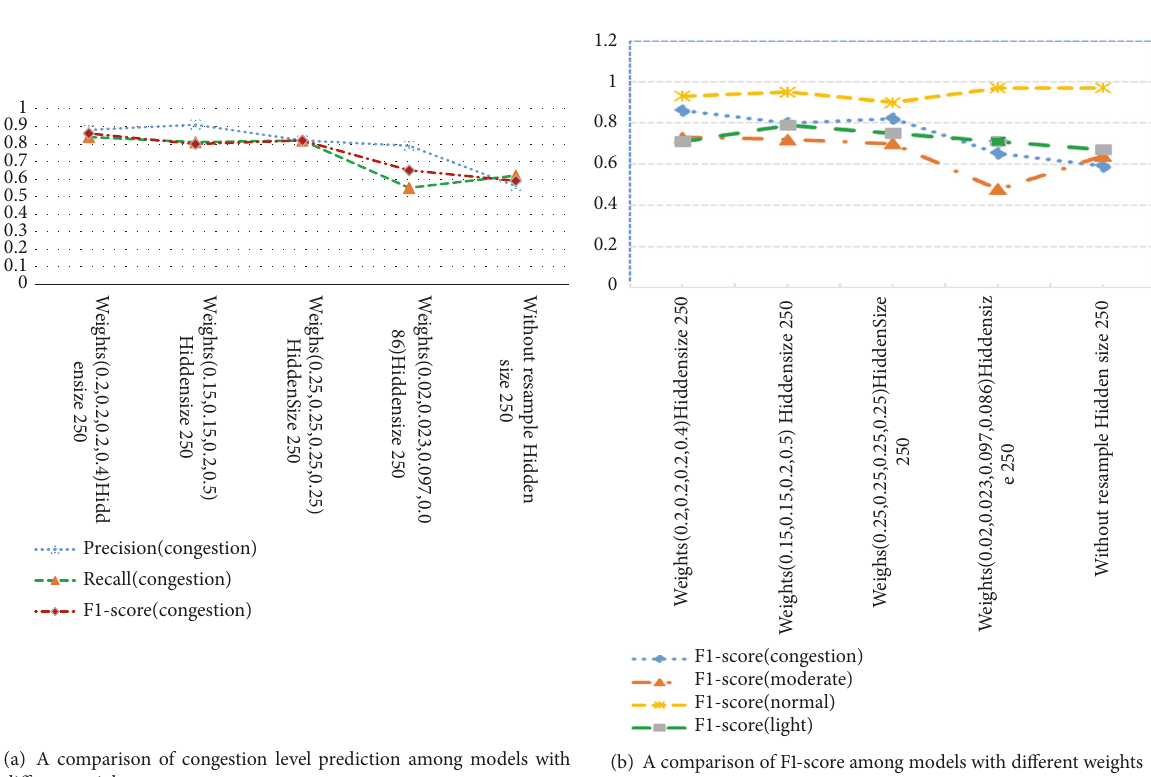
(b) A comparison of F1-score among models with different weights Figure 8: A comparison of performance among models with different